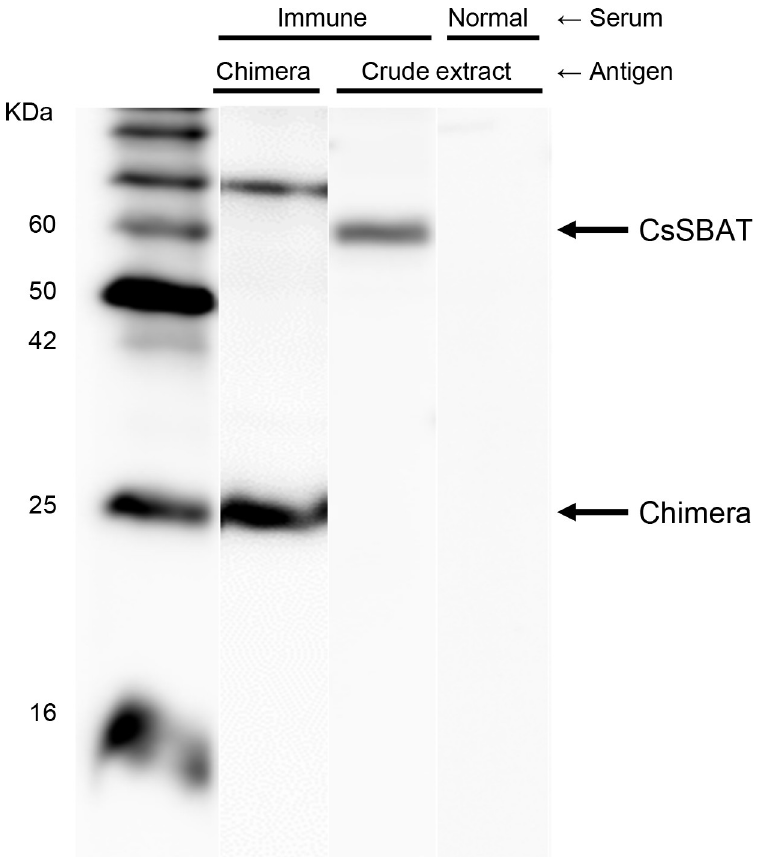
Fig 4. Reactivity of mouse anti-chimeric CsSBAT immune serum. The immune serum specifically detected native CsSBAT in an ECL immunoassay.